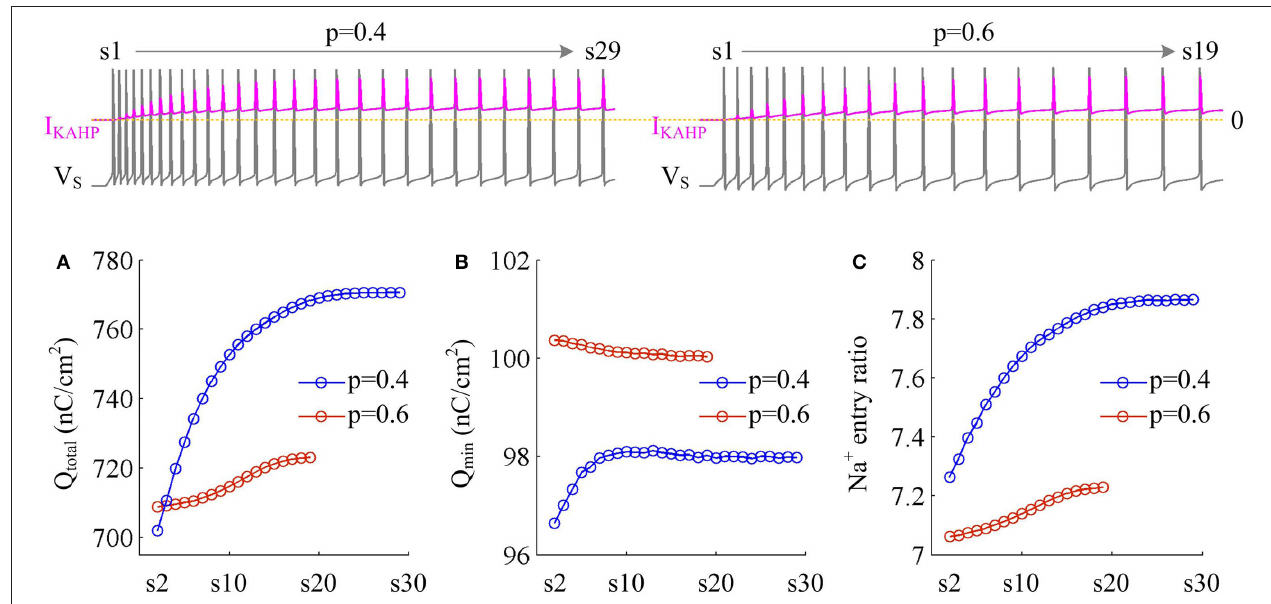
FIGURE 10 | Metabolic efficiency of the AP is reduced as I KAHP is activated. (A) Total Na + load Q total , (B) minimal Na + load Q min , and (C) Na + entry ratio are respectively calculated for each AP during the activation of I KAHP with p = 0.4 and 0.6. Top panels show the response of V S (gray) and I KAHP (pink) recorded in the model III with each value of p . Note that our examination starts from the 2nd AP, since I KAHP is totally unactivated during the 1st AP. I D = 2 µ A / cm 2 and g c = 0.6 mS / cm 2